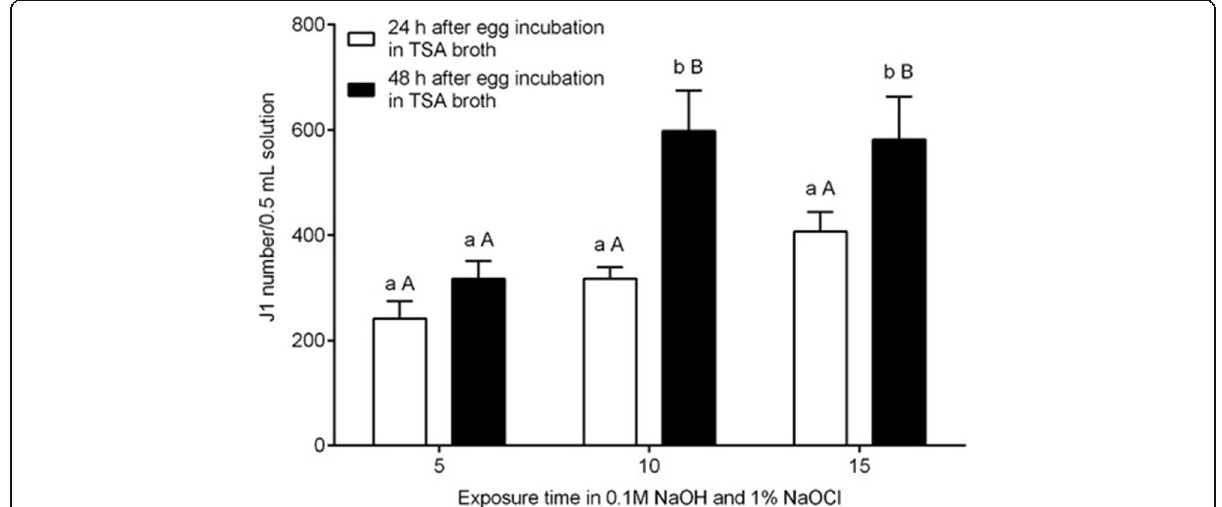
Fig. 4 Viable H. indica SL078 J1 s quantification. Significant differences among J1s at three exposure times (lowercase letters) and two incubation times (uppercase letters) were established by Tukey post hoc tests ( p < 0.05). Mean ± SEM ( n =